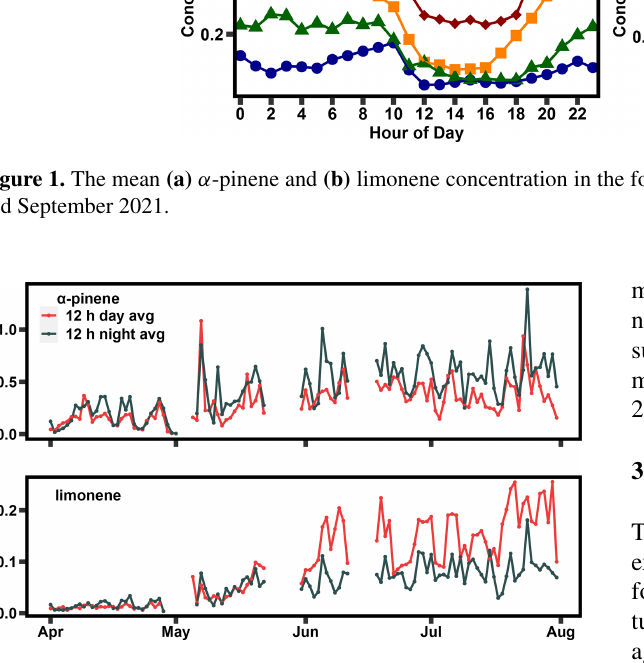
Figure 2. The 12h average of α -pinene and limonene between April 2021 and August 2021. The averaging period for each com- pound was between 07:00 and